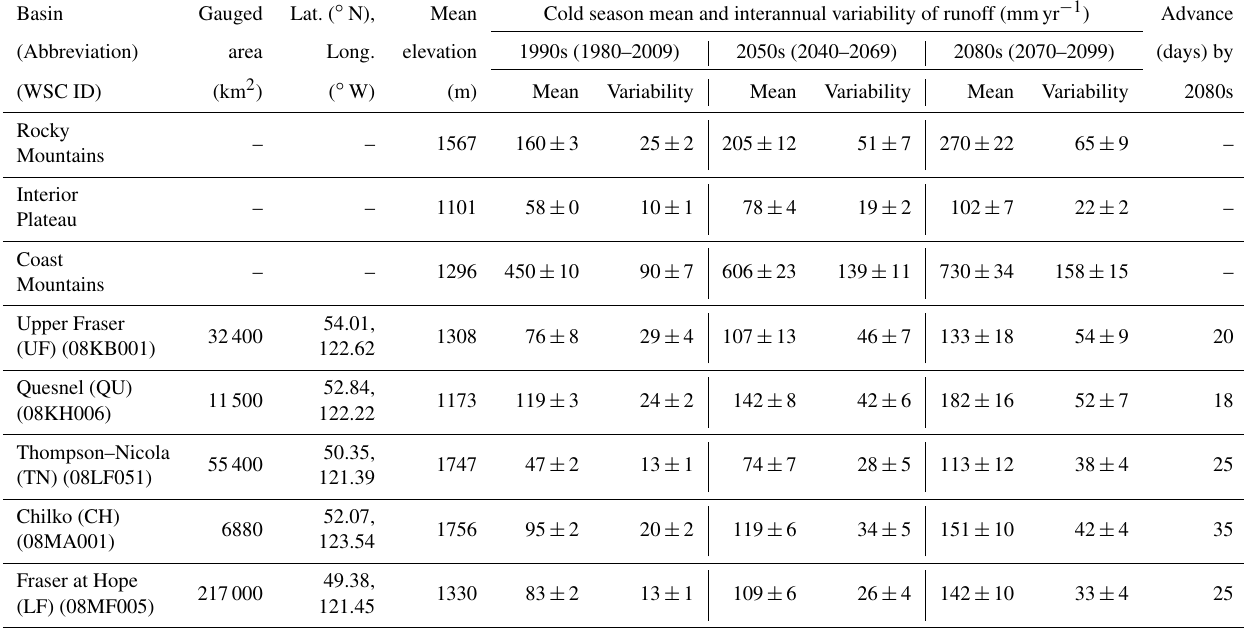
Table 1. Characteristics of the Water Survey of Canada (WSC) hydrometric stations and three geoclimatic regions within the FRB (Déry et al., 2012). The 30-year runoff mean and interannual variability (estimated by standard deviation) is calculated for each individual CMIP5-VIC simulation, and all values are averaged to get the MME mean in the cold season. The inter-model spread in runoff mean and its interannual variability are indicated as uncertainty ranges ( ± ) estimated by a 5%–95% model range. The last column shows advances in the timing of the MME mean annual peak flow by